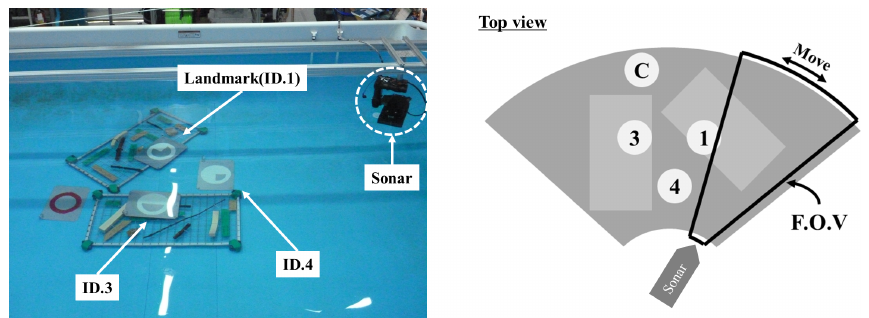
Figure 12. Experimental setup for multi-object